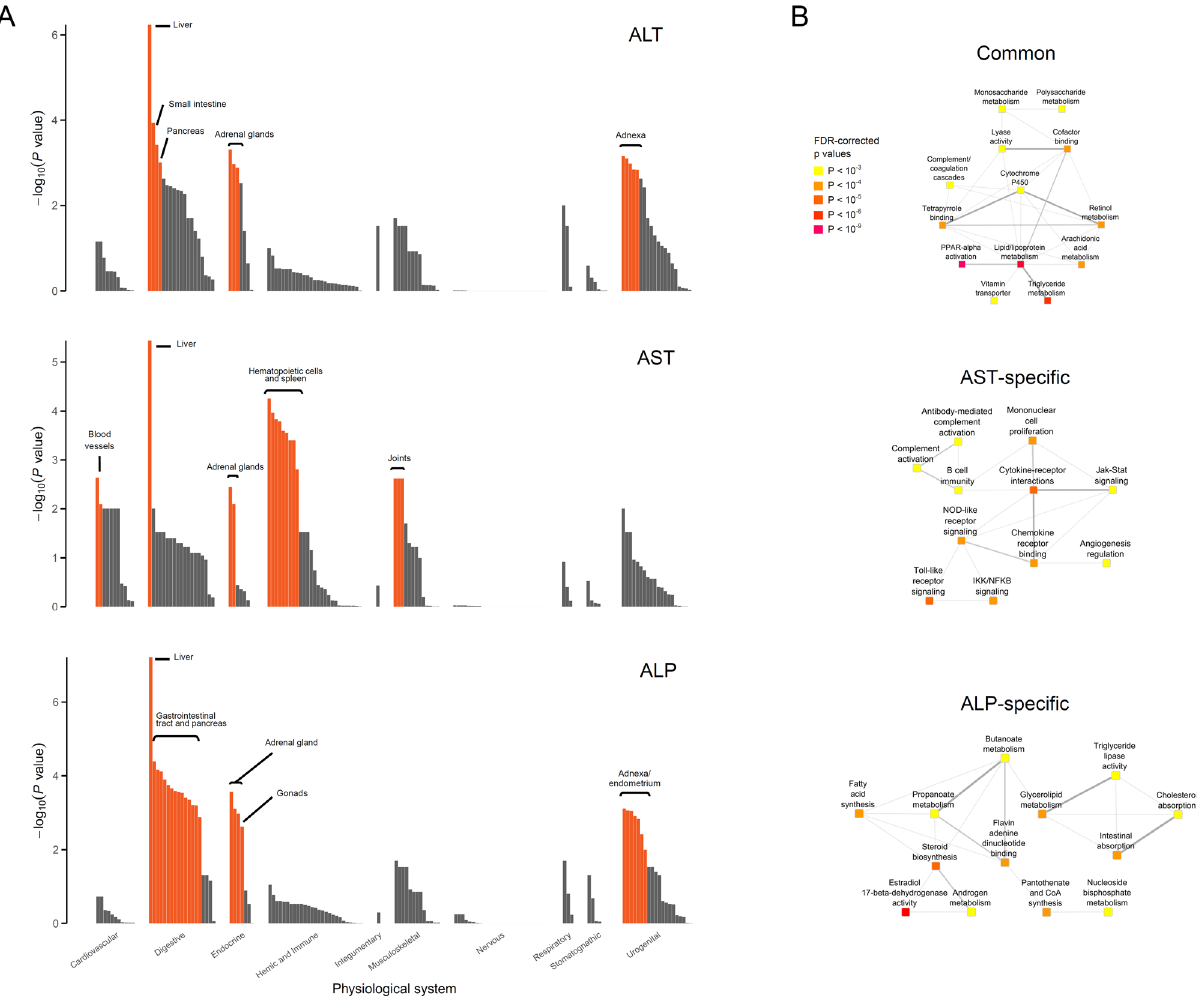
Fig. 3 DEPICT analysis of liver enzyme-associated variants. A Tissue enrichment of alanine transaminase (ALT), aspartate transaminase (AST), or alkaline-phosphatase (ALP) associated genetic variants. Height of the bar represents – log 10 p-value. Orange shading represents statistical signi fi cance at false discovery rate (FDR) < 0.05. B Network plots depicting gene sets enriched in all three sets of ALT-, AST-, and ALP-associated variants ( “ Common ” ), in gene sets enriched only among AST-associated variants ( “ AST-speci fi c ” ), and in gene sets enriched only among ALP-associated variants ( “ ALP- speci fi c ”